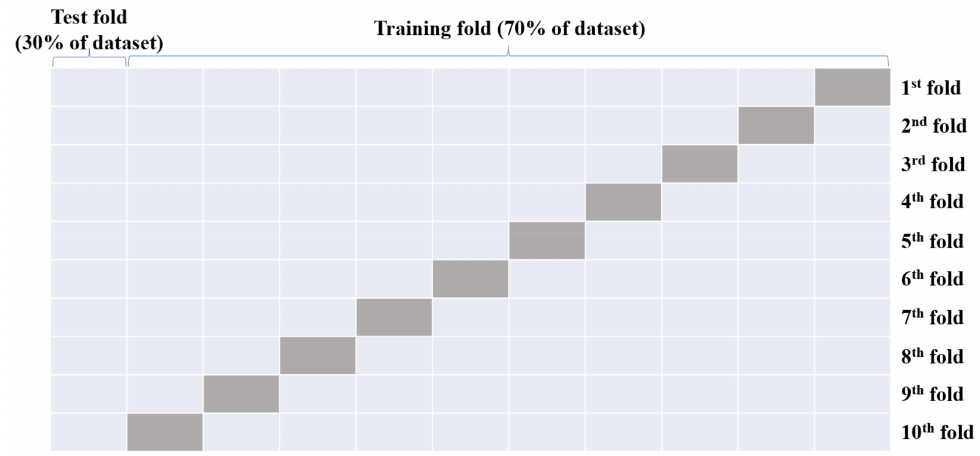
Figure 4. A 10-fold cross